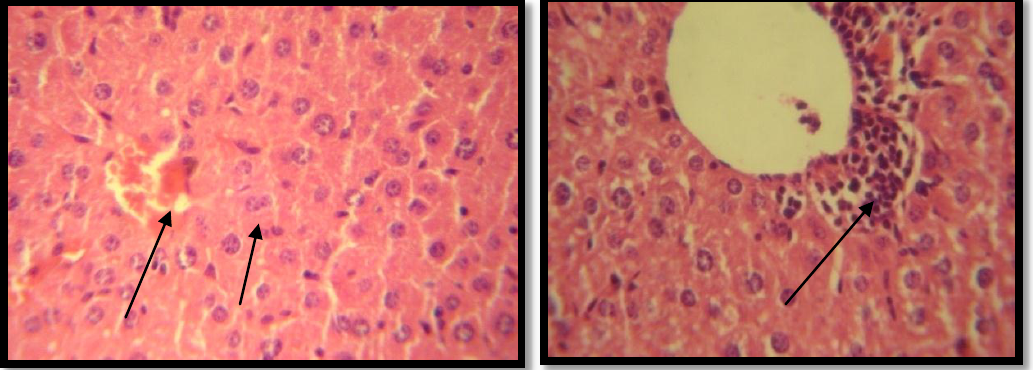
Figure 1: Histopathopathological section of the liver of the mouse treated with 16mg/kgbw of pentoxifylline for1month showing dilation and congertion of central veins( ) with kupffer